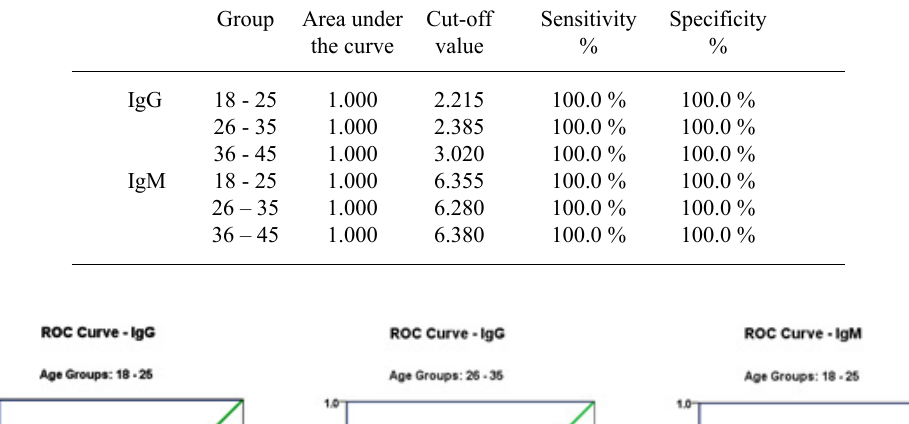
Table 3. roC-Curve of Igg and IgM olaccording the age groups